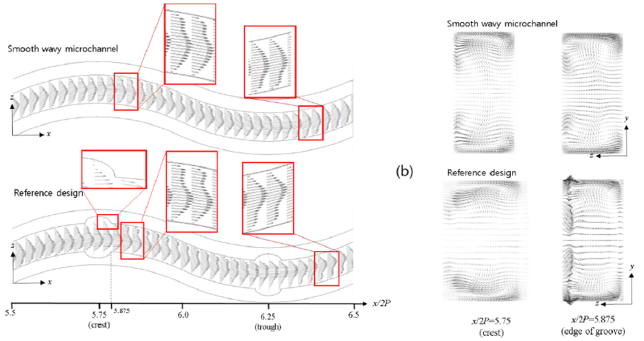
Figure 10. Local Nusselt number distributions on wavy walls: ( a ) smooth microchannel and ( b ) reference design.